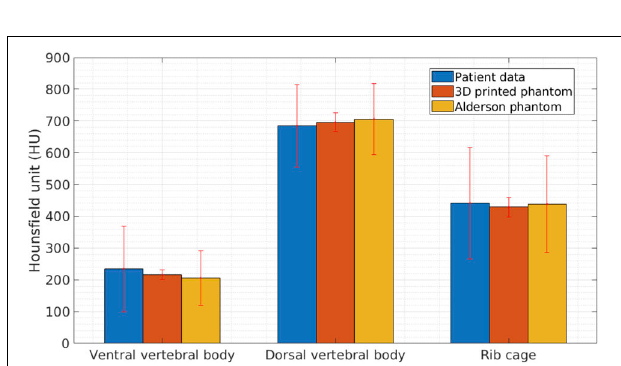
FIGURE 7 | Corresponding axial sections from CT scans of patient, 3D printed thorax phantom and Alderson phantom and twelve printed ribs. Axial sections from CT scans of (A) Patient, (B) 3D printed thorax phantom, (C) Alderson Rando anthropomorphic thorax phantom. Axial sections from CT scans of 3D printed thorax phantom showing (D) Incorporation of air bubble (indicated by red arrow and box), (E) Replication of inhomogeneity in the ventral vertebral cancellous bone (magnified view in the red box), (F) CT scan of the rib specimens for reproducibility tests of the radiopaque amalgamate and model geometry.